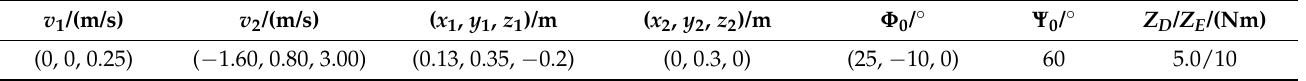
Table 4. Known values during optimization for example 2.